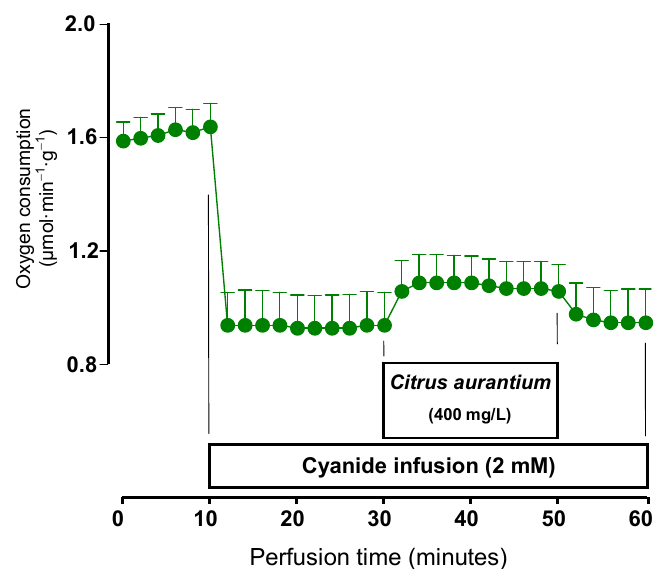
Figure 4. Effects of the C. aurantium extract on oxygen uptake in the presence of cyanide. Livers from fed rats were perfused as described in the Experimental Section. The infusion of cyanide was started after stabilization of oxygen uptake. The times at which infusion of cyanide and C. aurantium extracts (400 mg/L) were started are indicated. Oxygen consumption was followed polarographically. Each datum point represents the means of three liver perfusion experiments. Bars are standard errors of the